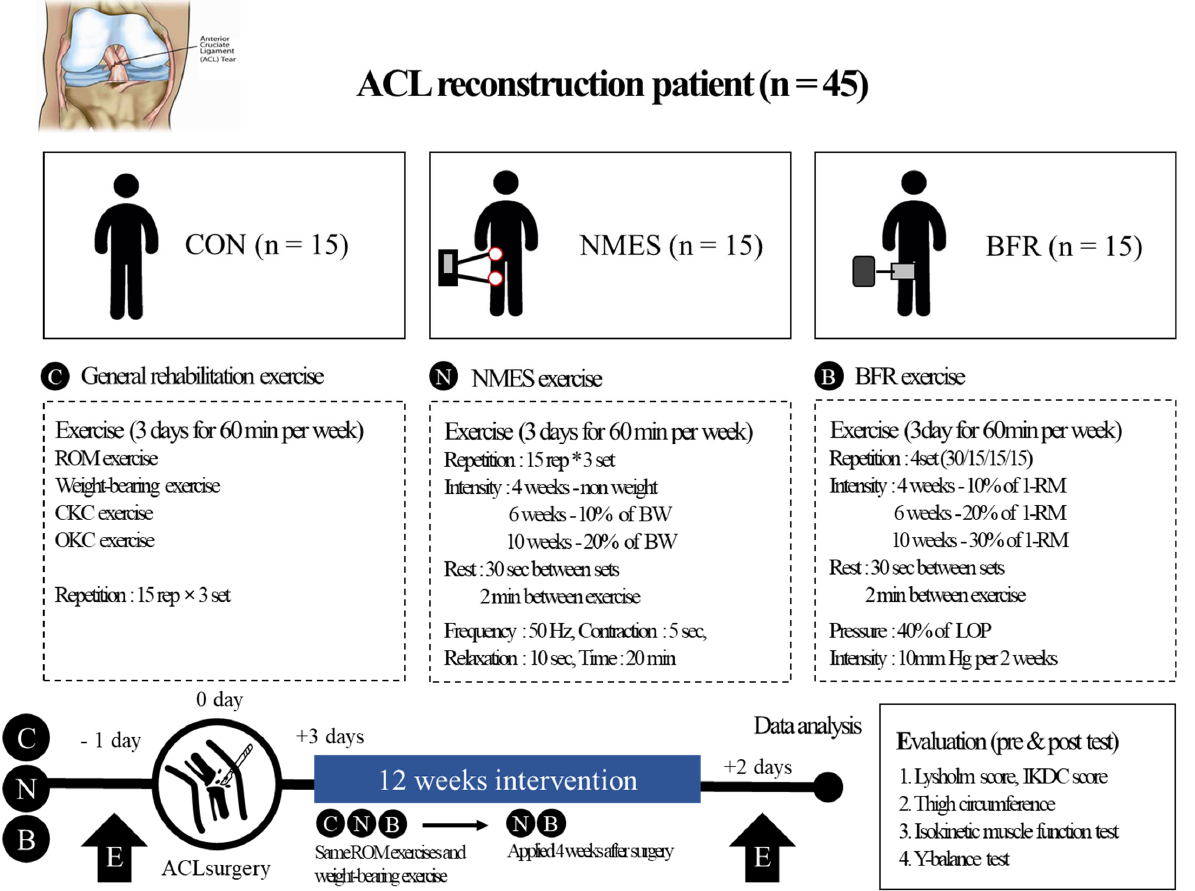
Figure 2. Study design. CON, control; NMES, neuromuscular electrical stimulation group; BFR, blood flow restriction group; CKC, closed kinetic chain; OKC, open kinetic chain; RM, repetition maximum; SBP, systolic blood pressure; IKDC, International Knee Documentation Committee; ROM, range of motion; ACL, anterior cruciate